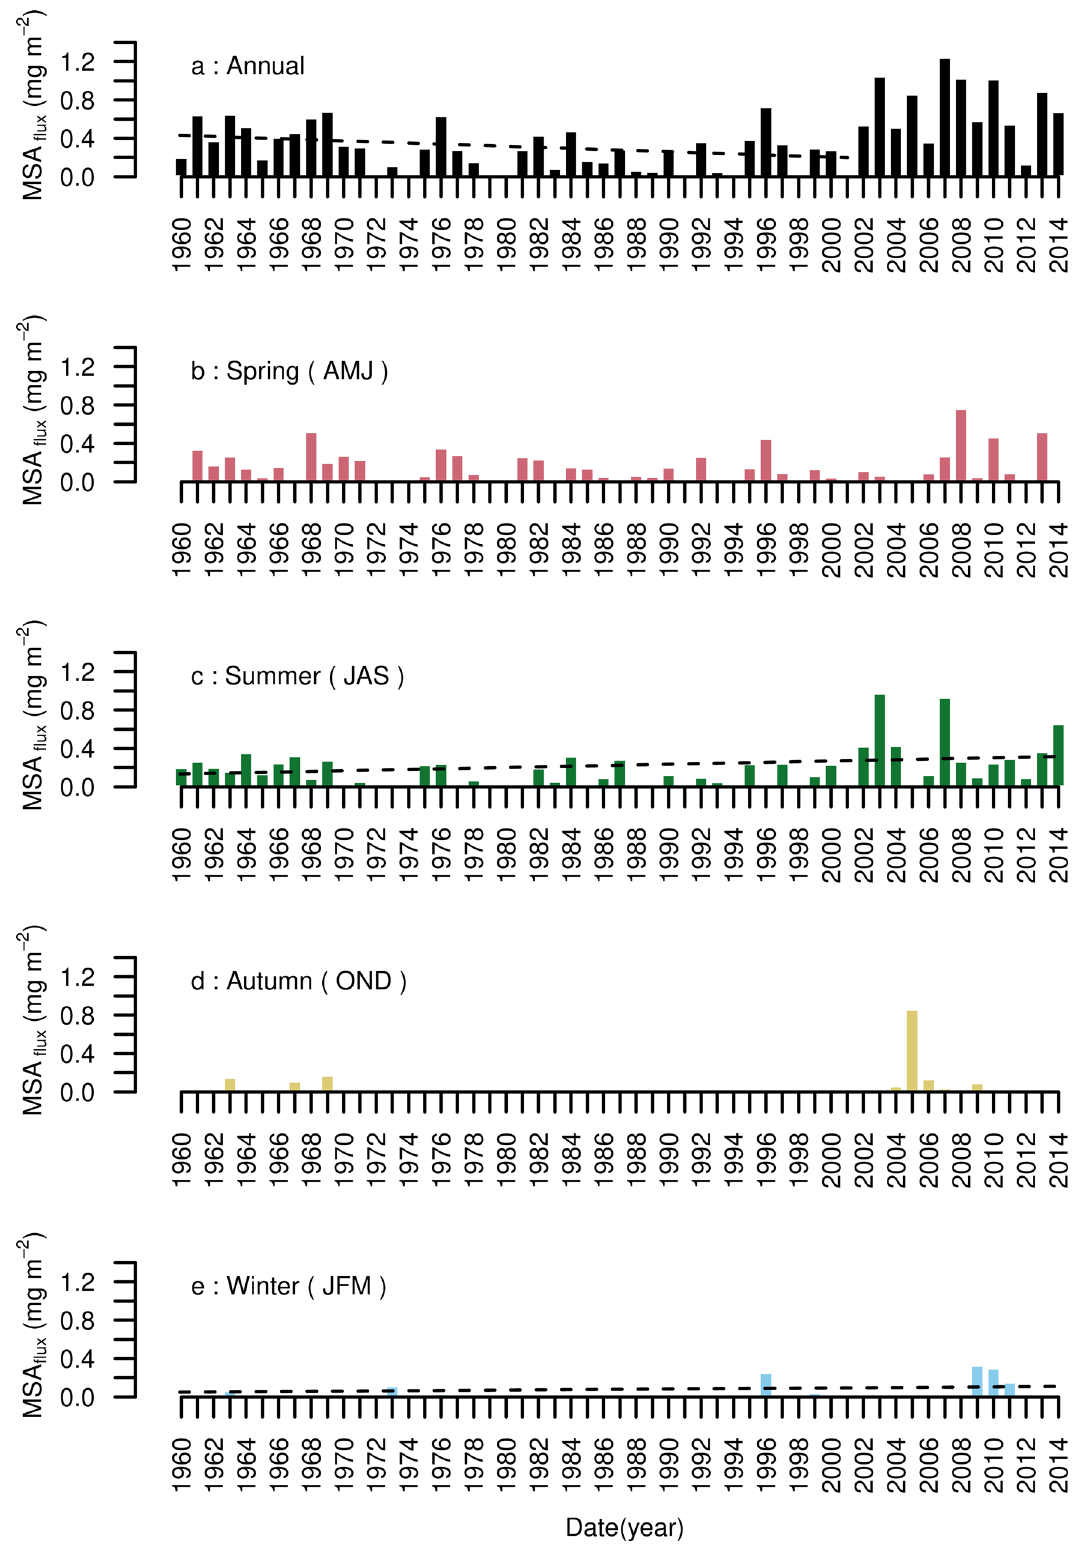
Fig. 2 Interannual variations in MSA fl ux . a – e denote the interannual variations in MSA fl ux of annual and each season ( a : January – December, b : January – March, c : April – June, d : July – September, e : October – December). Black dashed lines are regression lines.